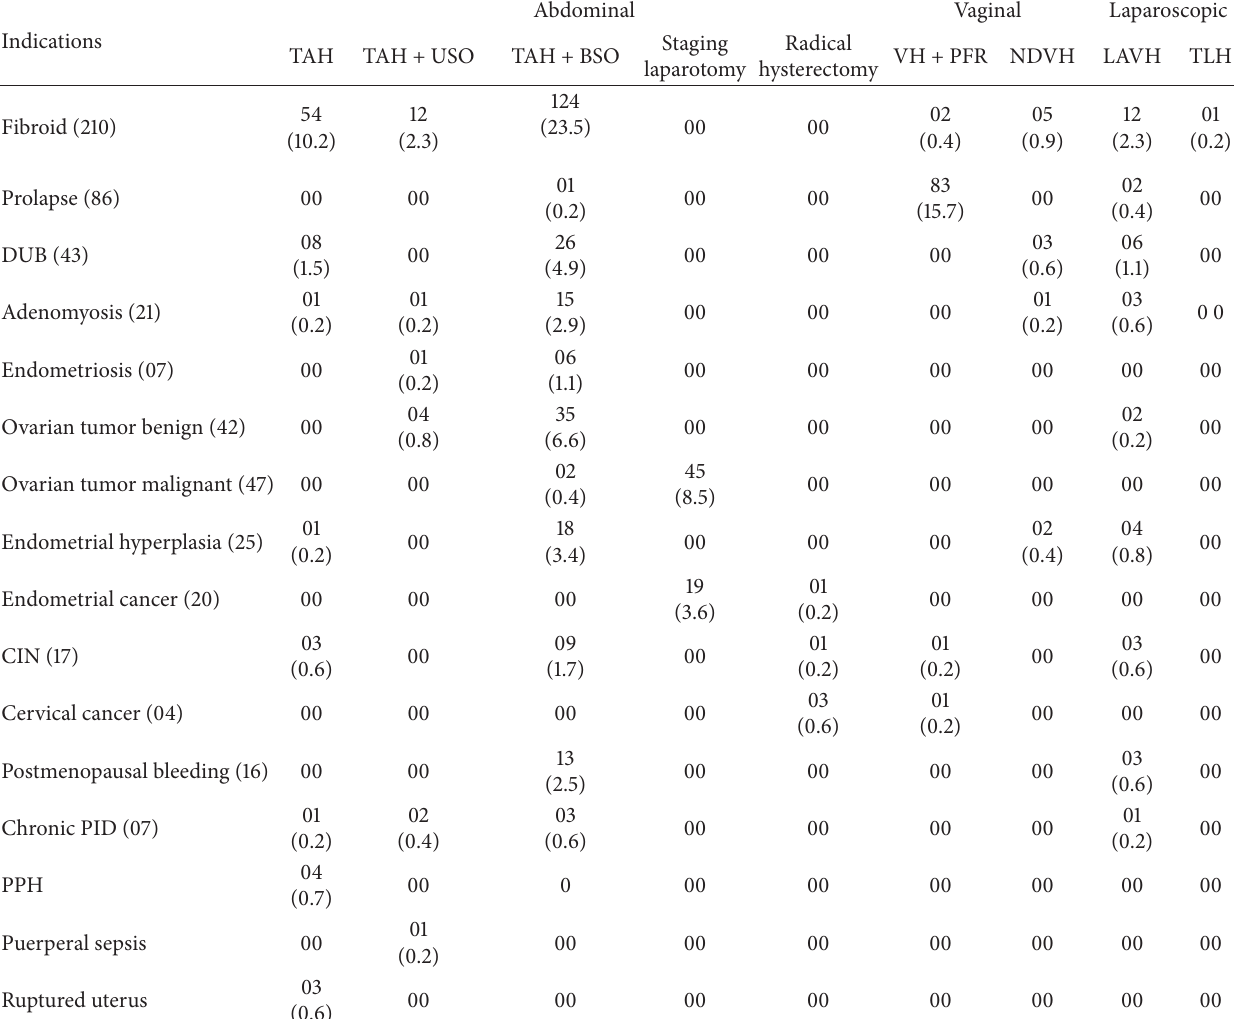
Table 3: Indication of hysterectomy in relation to the